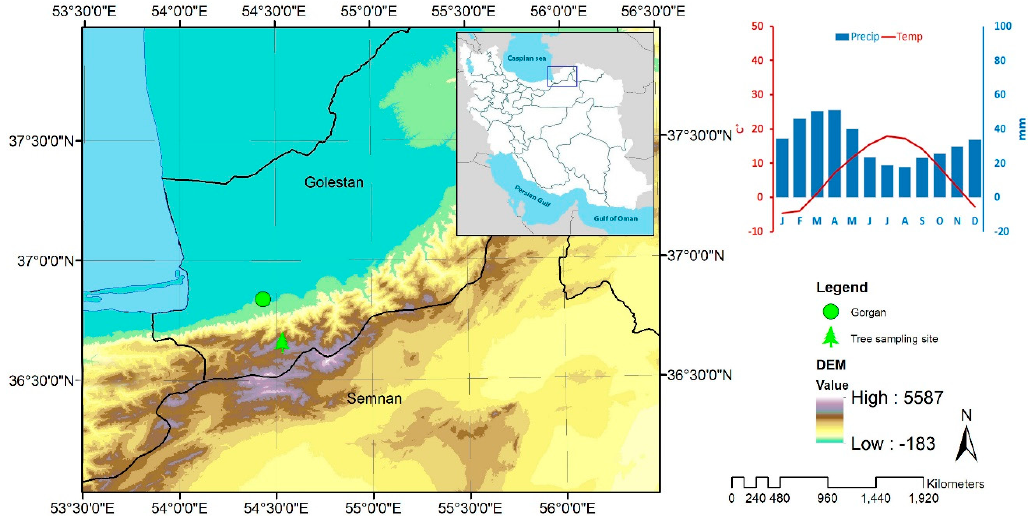
Figure 1. Map of the study site and location of Gorgan climate station. Inlay: Climate diagram of the modeled data for the study site.